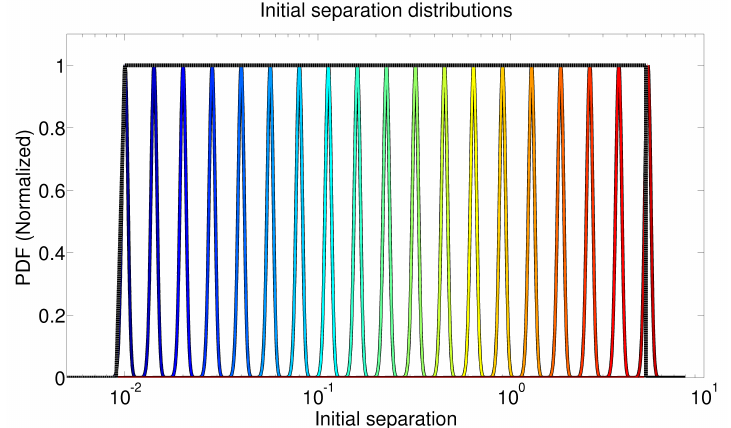
Figure 2. Schematic representation of the initial separations used in this study. The reference initial condition consists of a Heaviside distribution between 0.01 and 5 (black/grey dashed line). The Dirac distributions (approximated as narrow Gaussian distributions), centred at some varying reference separations are used in the study of the dependence of FSLE to initial conditions (Section 5), and are represented as colored